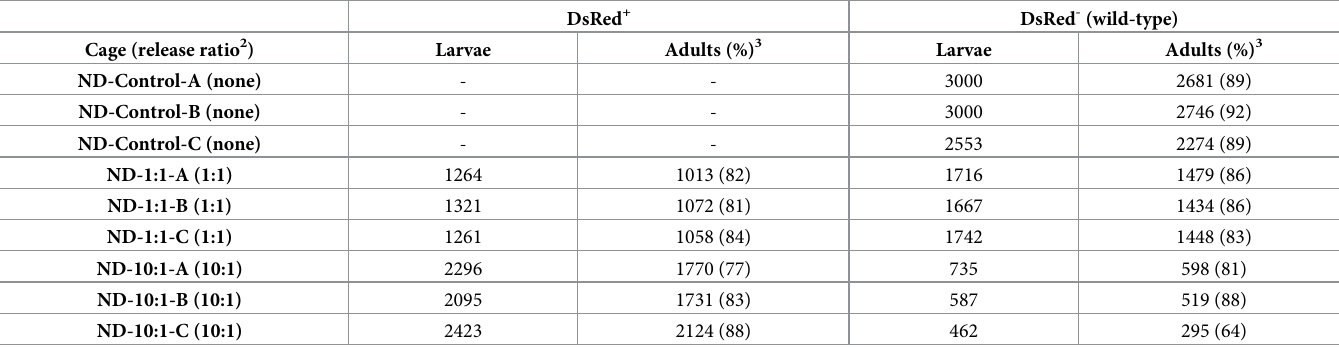
Table 1. Larval to adult survival in non-drive cage trials 1 .